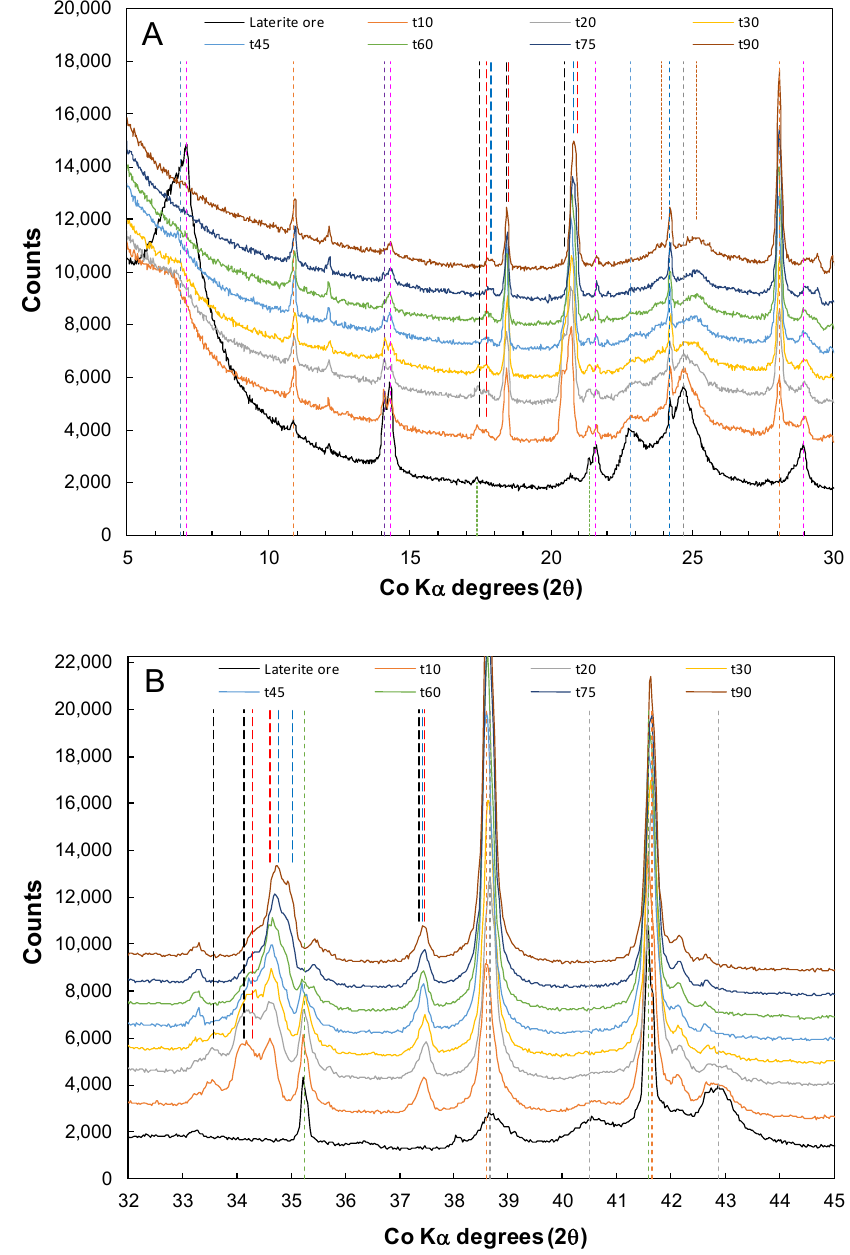
Figure 2. XRD patterns for selected angle ranges of the feed ore and samples (t10, t20, t30, t45, t60, t75, and t90) taken during the HPAL of 30% w / w blended nickel laterite ore in site water at 250 ◦ C using 364 kg / t dry ore acid addition. Selected peaks positions ( ◦ 2 θ ) are shown for the following minerals: nontronite (6.85, 22.82), clinochlore (7.07, 14.33, 21.57, 28.94), talc (10.90), lizardite (14.12), quartz